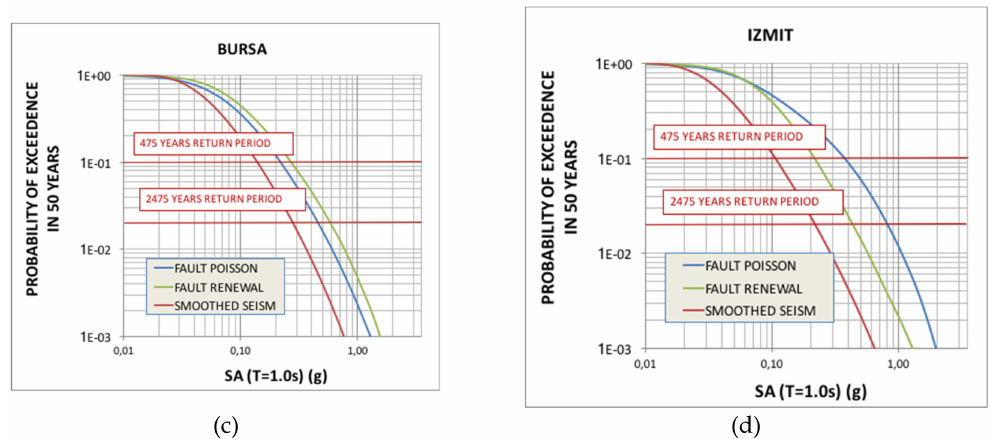
Figure 16. The 5% damped spectral acceleration (SA) at T = 1.0 s hazard curves for ( a ) Istanbul, ( b ) Tekirda˘g, ( c ) Bursa, and ( d ) Izmit (Kocaeli) considering the individual Poisson, renewal-BPT, and smoothed seismicity source models.